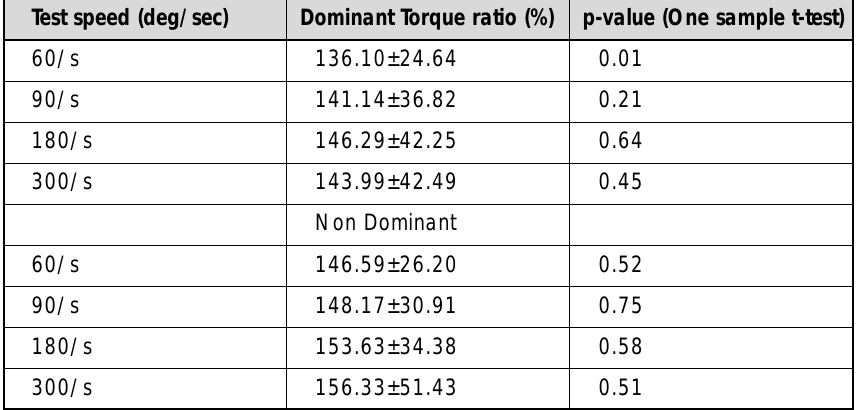
Table 2: Comparison of mean torque expressed in percentages of internal rotation and external rotation.